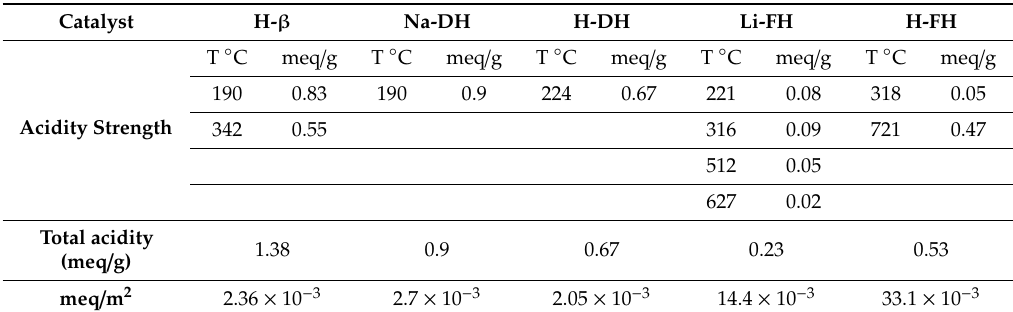
Figure 5. NH 3 -TPD of catalysts: ( a ) Na-DH, ( b ) H-DH, ( c ) Li-FH, ( d ) H-FH. Table 4. Acidity results obtained by NH 3 Table 4. Acidity results obtained by NH 3 -TPD.